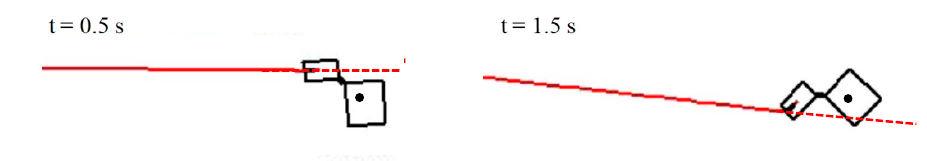
Figure 11. Shape of the system by numerical simulation.